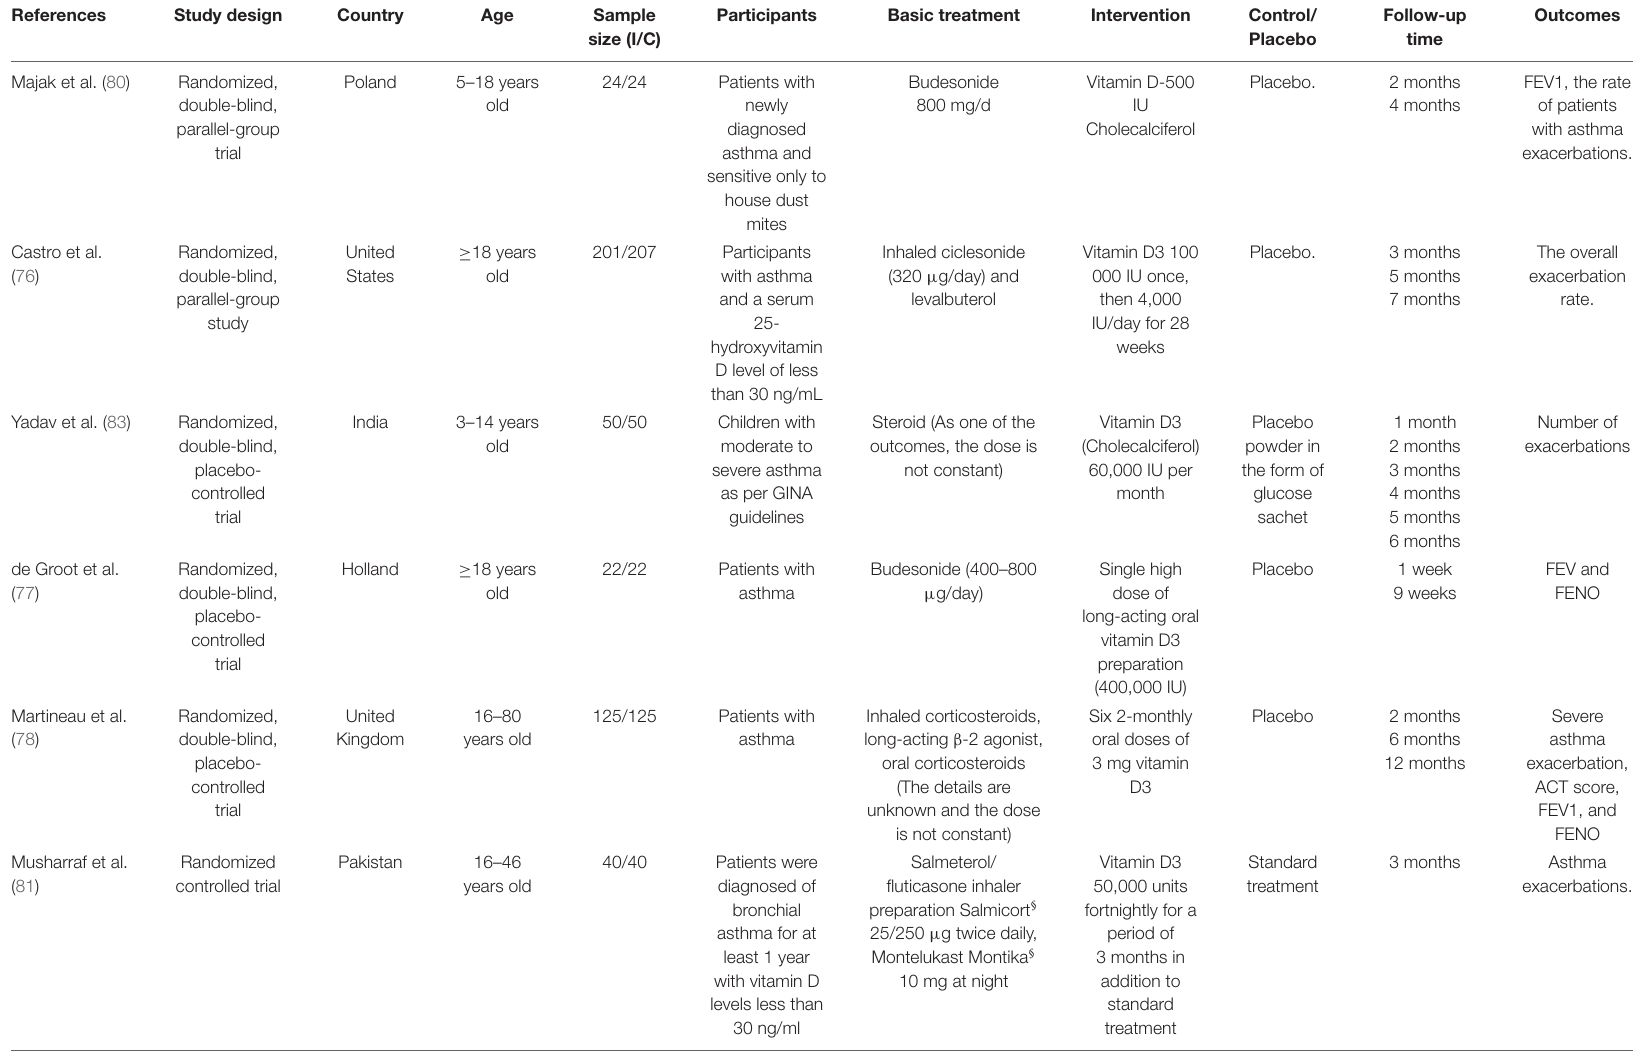
TABLE 1 | Summary of the included articles in this